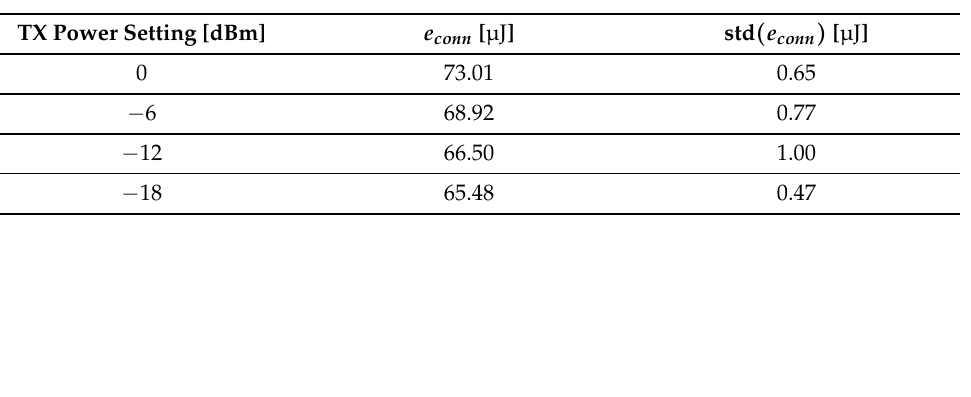
Table 1. Energy consumption of BLE connection events for different TX power